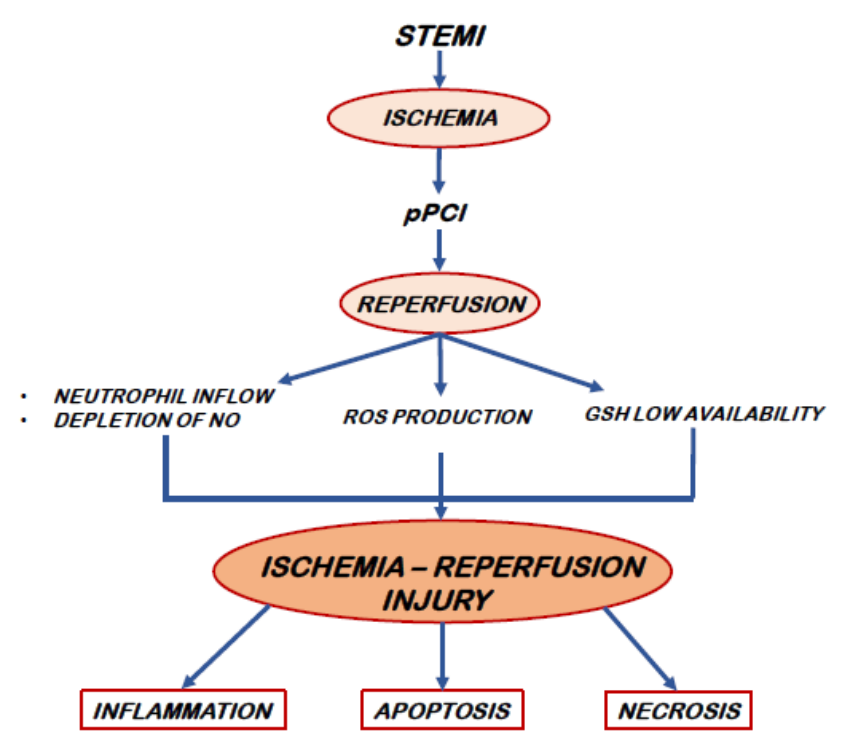
Figure 1. The pathophysiology of IRI. Abbreviations. STEMI: ST-elevation myocardial infarction, pPCI: primary PCI, NO: nitric oxide, ROS: Reactive Oxygen Species, and GSH: glutathione.